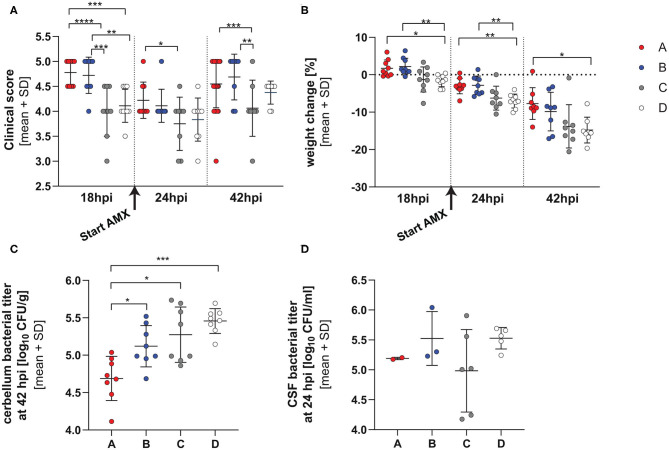
Clinical parameters in infection with single RMS allele variant. Clinical score (A), weight change (B) and bacterial titers in cerebellum at 42 hpi (C) and CSF at 24 hpi (D) in animals infected with the 4 different hsdS allele variants (A: n = 8, B: n = 8, C: n = 8, D: n = 8). The vertical dotted lines represent separation between the different time points and the initiation of the amoxicillin treatment is indicated by an arrow under the x-axis. The variants show altered virulence measured by the clinical score, weight change and cerebellum titer. The detailed statistical analyses are provided in Supplementary Tables 1, 2. *p < 0.05; **p < 0.01; ***p < 0.001; ****p < 0.0001.